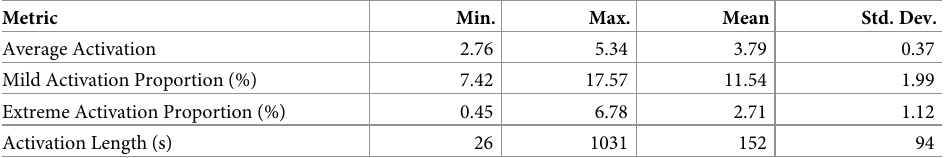
Table 1. Summary statistics of four PP activation metrics. Average activation is a dimensionless quantity. Mild and extreme activation proportions are measured in percentages (%). Activation length is measured in seconds (s). Metric